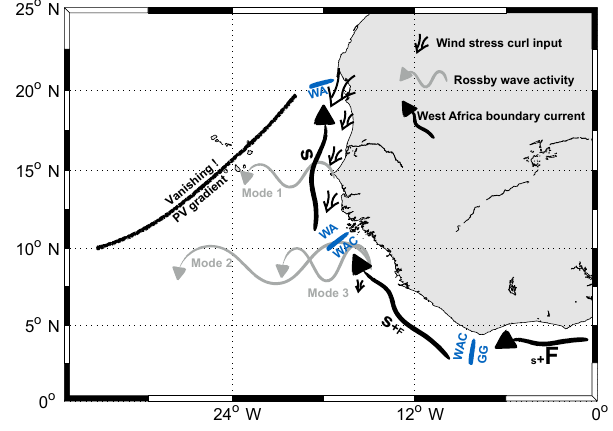
Figure 18. Schematic representation of the main processes rele- vant for the WABC seasonal cycle as identified in this study. Two WABC intensification phases occur in spring (S) and fall (F) in re- lation to the relaxation of cross-shore Ekman transport along dif- ferent sectors of the African coast. The relative importance of each sector varies depending on the season. The font size of the S and F letters next to the WABC arrows is indicative of this importance. Three sectors are distinguished: the Gulf of Guinea (GG), the West African corner (WAC), and West Africa (WA). The fall intensifica- tion is mainly due to wind changes in the GG and a modest contri- bution from the WAC. The spring intensification is the outcome of a subtle combination of forcings in all three sectors with a promi- nent role of local WA forcings. The spatiotemporal variability of the wind stress curl forcing does not have an appreciable effect on the WABC seasonal cycle, although it is a key local determinant of the climatological mean meridional transport along WA (weak near 8–10 ◦ N and particularly strong near 20 ◦ N). The WABC is subjected to scattering and gives rise to Rossby wave (RW) activity hundreds to thousands of kilometers offshore. The characteristics of these RWs exhibit rapid meridional changes over a few degrees of latitude. At low latitude ( ∼ 8) where β is largest RWs associ- ated with baroclinic modes 2 and 3 dominate. At 14 ◦ N where only mode 1 RWs are permitted the model RWs significantly differ from those predicted by standard linear theory. This discrepancy and the progressive disappearance of RW activity north of 15 ◦ N may be related to the peculiar structure of the upper ocean ETNA PV field: above approx. 250m of depth the gradient of the background PV field ( β + stratification effects) vanishes along a line running north- east to southwest.